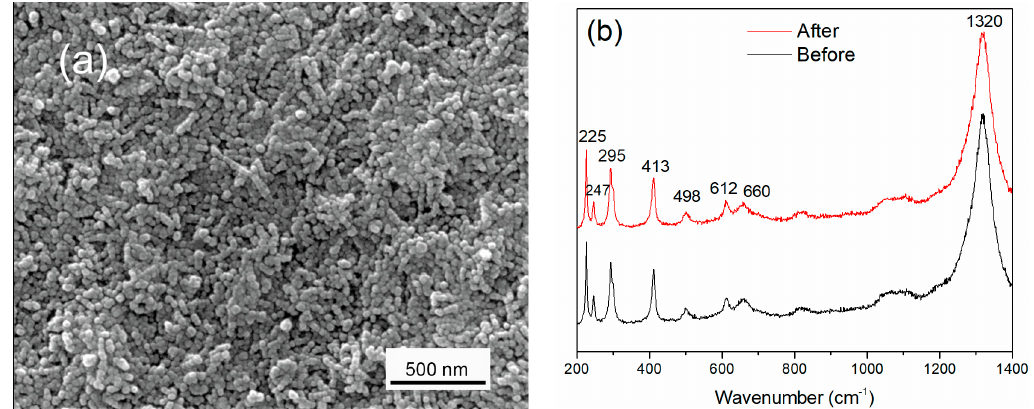
Figure 1. ( a ) ESEM image of hematite electrode; ( b ) Raman of hematite electrodes before and after interplay with PAO1.